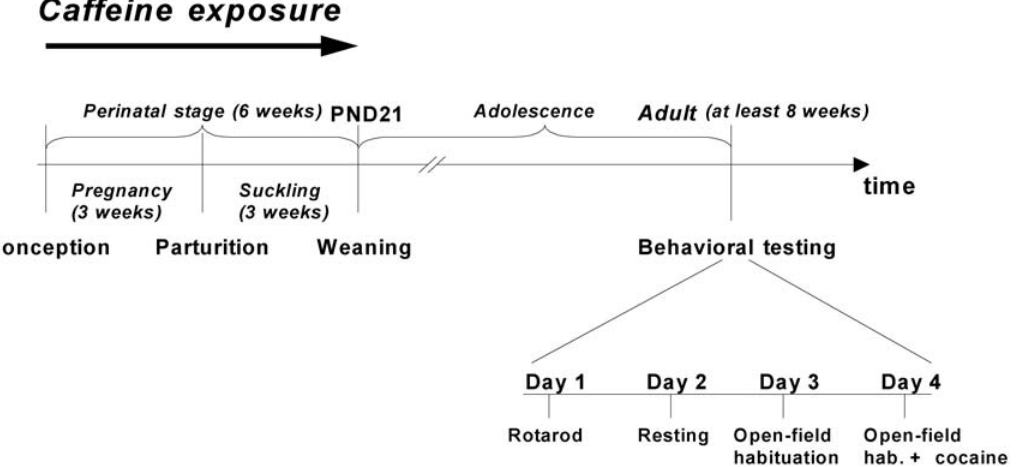
Figure 1. Experimental design. Pregnant WT females were divided in two groups: one exposed perinatally to 0.3 g/l caffeine (WT Caff), the other receiving tap water (WT H 2 O) from GD1 to day 21 of lactation (PND21). After the separation from the mother, the offspring were housed 2–8 per cage (males and females separately). At 2 months of age mice were tested at the rotarod, and then allowed to rest for one day and on the day 3 let to spontaneously explore an open field for two separate 45 min sessions. The sessions were separated by a 2 h resting period. Following the open-field habituation and test on day 4, the animals were sacrificed by means of decapitation and their brains were dissected out and stored at 2 80 u C.